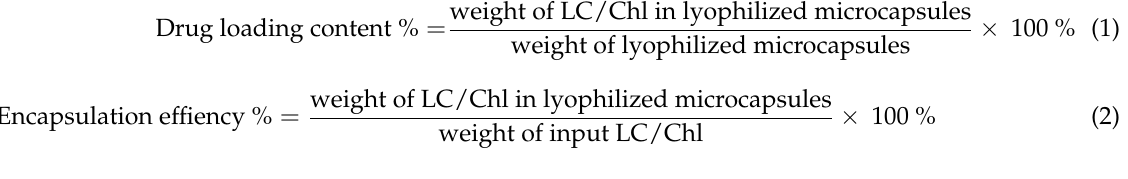
Table 1. The hydrodynamic particle size and PDI with different ratios of Chl to LC, measured by DLS. Ratio of Chl to LC Particle Size (nm)